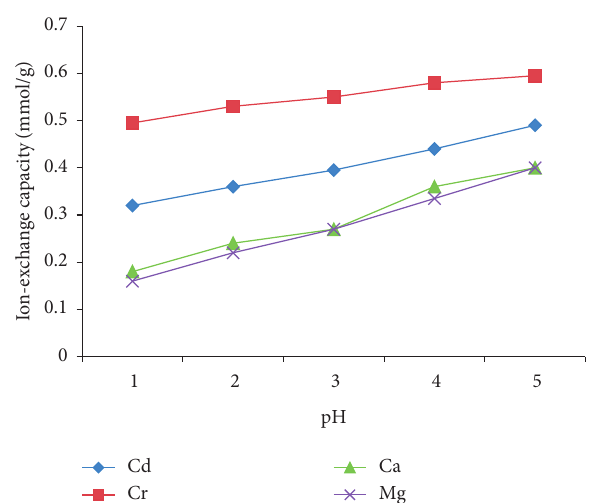
Figure 10: The metal uptake capacity of the SCF resin as a function of Table 1: Equilibrium concentration of metal ions at different time intervals for three different resins (“Dowex” 50-X8, ACF, and SCF). Metal ion Time (minutes)